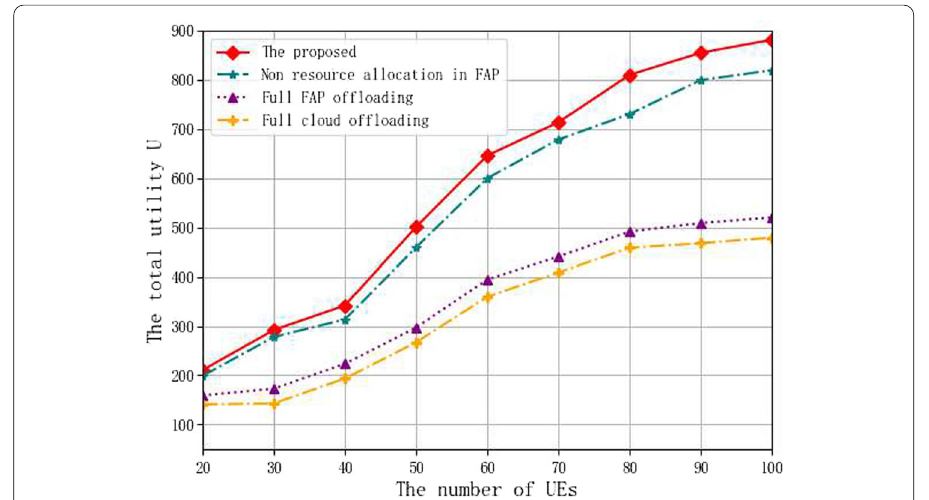
Fig. 10 The total utility of UEs versus the number of UEs